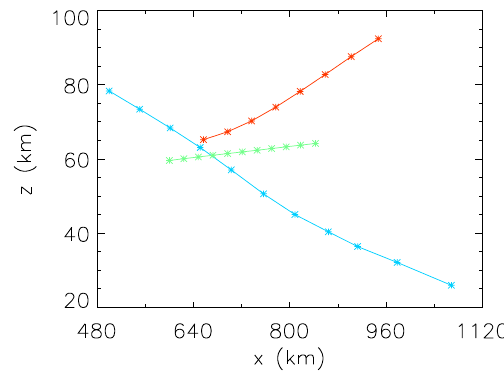
Fig. 6. Propagation paths of interacting waves. The cyan, green and red lines denote the paths of waves 1–3, respectively. The asterisk denotes the position of wave energy centre at each integer hour, and the position of wave 3 is presented from t =